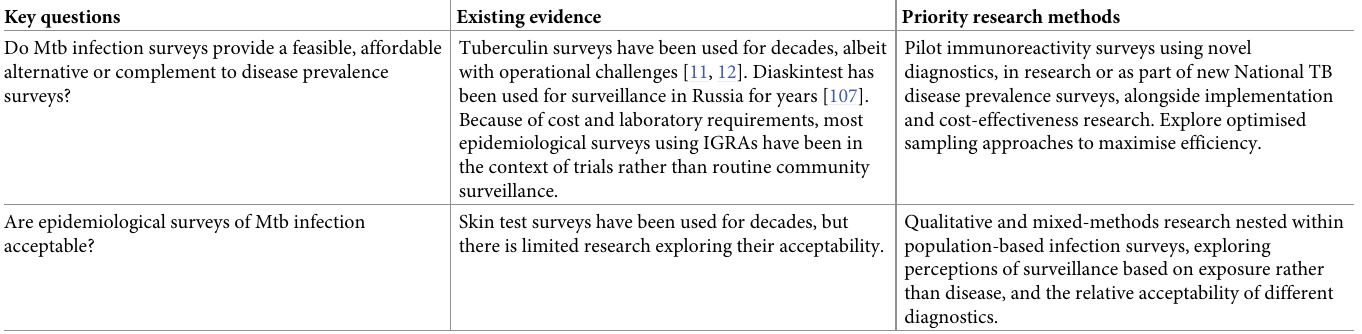
estimate at different levels of relative precision. The upper panel encompasses the range of prevalence of Mtb infection commonly observed in high-prevalence settings, while the lower panel zooms on the usual range of prevalence of TB